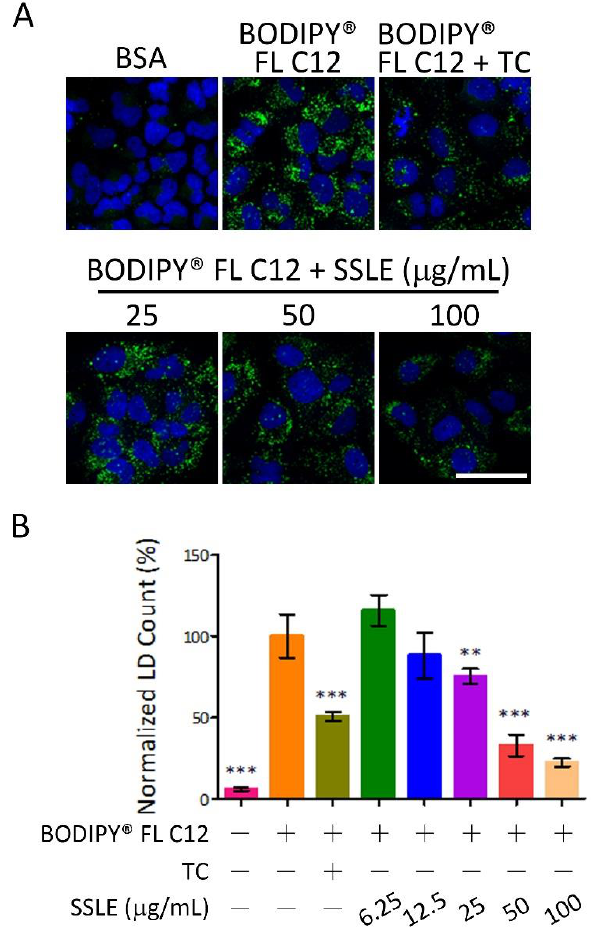
Figure 5. SSLE reduced fatty acid uptake. BODIPY-labeled dodecanoic acid (BODIPY ® FL C12) was conjugated to BSA and used as the fatty acid source in the LD assay. Huh7 cells were treated as indicated for 9 h, then fixed and stained with Hoechst 33342. ( A ) Representative images; ( B ) Quantification results. The concentration of BODIPY ® FL C12 and TC were 125 µM and 1 µM, respectively . Bar: 50 μm. * significant difference from OA control group (** p < 0.01, *** p < 0.001, compared with controls using the one-way ANOVA and Dunnett ’ s